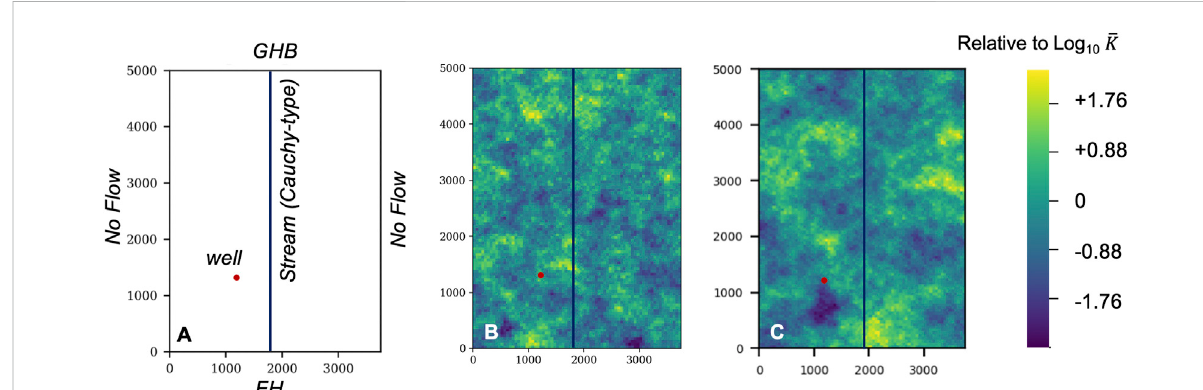
FIGURE 1 (A) Synthetic case model structure and boundary conditions with a General Head Boundary Condition (GHB) of 40 m to the upper boundary and a Fixed Head (FH) of 20 m to the lower boundary. No fl ow is imposed at the left and right domain boundaries. The stream is simulated with a